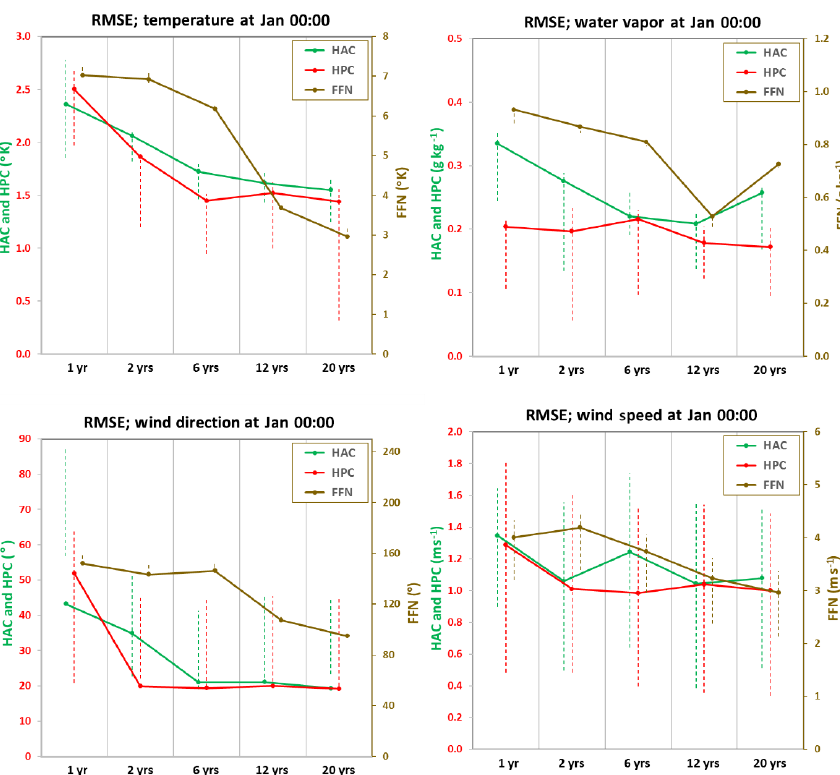
Figure 6. RMSEs for temperature, water vapor, and wind components at midnight in January using three DNNs. Left y axis is for RMSEs of HAC and HPC; right y axis is for RMSEs of FFN. The RMSEs are calculated along the time series below the PBL height for January midnight at local time. The lower and upper end of the dashed lines are RMSEs that consider the lowest and highest PBL heights as shown in Fig. 2. Table 2. Training and prediction time (unit: seconds) for the three DNNs using a different number of years for training. The predicted period is for 1 year